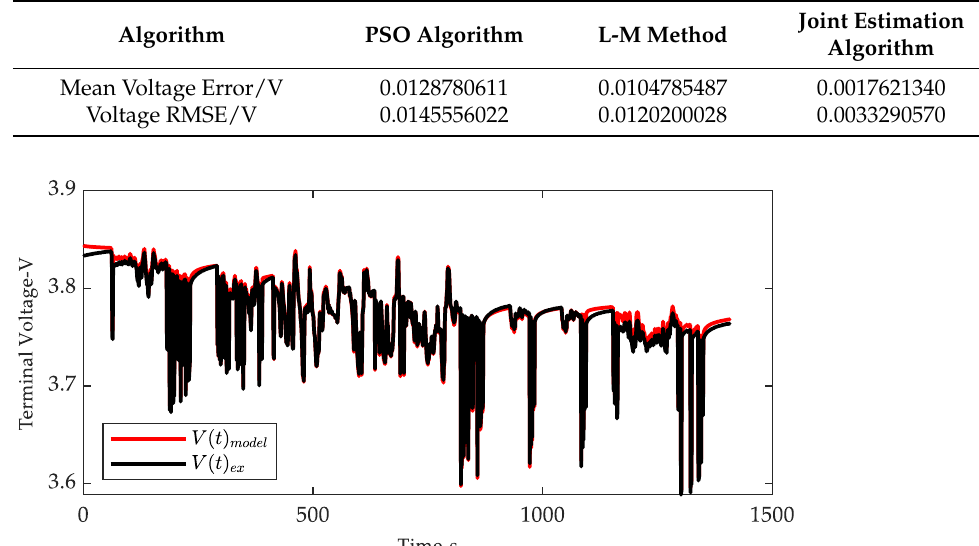
Figure 8. Model output voltage error curve based on the second group of testing data.